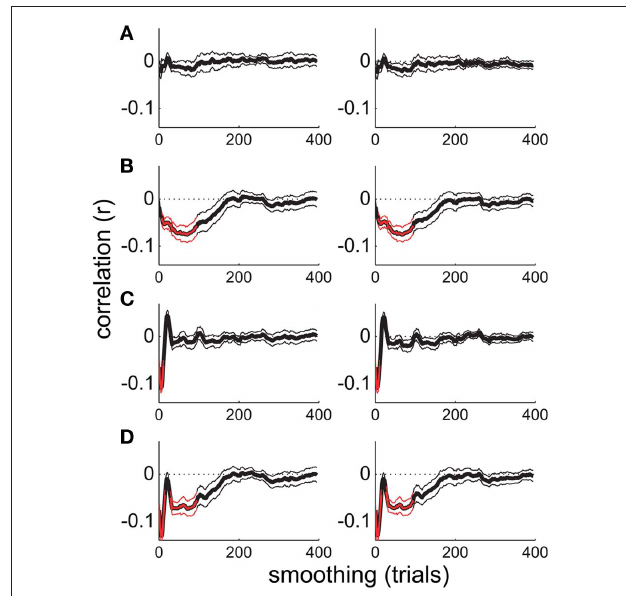
Figure 6 | Smoothed time series correlation analysis performed on simulated time series. (A) Uncorrelated time series. (B–D) Time series negatively correlated at long timescales, short timescales, and both long and short timescales, respectively. Thin lines show the SE of the mean across the 12 pairs of simulated time series.